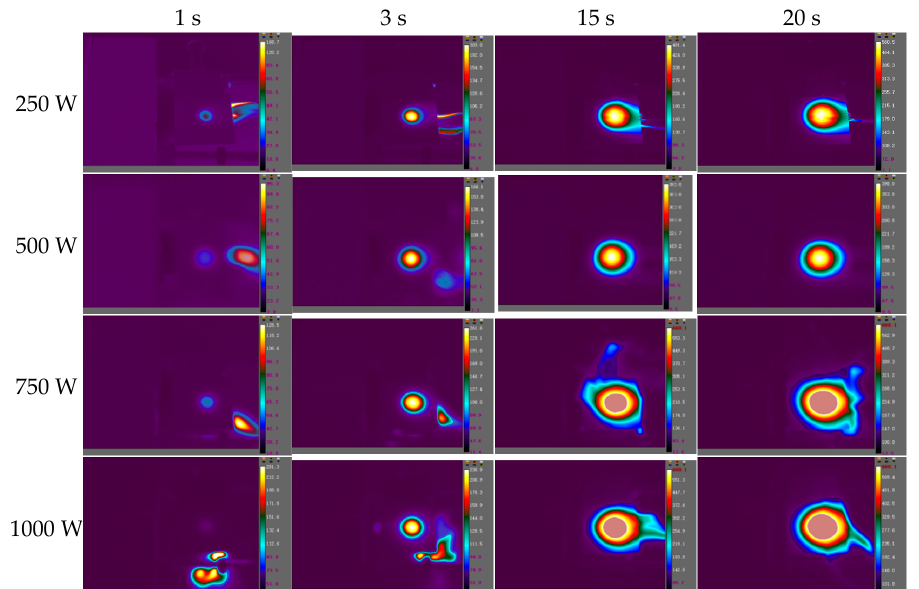
Polymers 2022 , 14 , x FOR PEER REVIEW Figure 15. The images of the temperature field on the CFRP laminated back surface irradiated by different laser power in the air environment at different times.